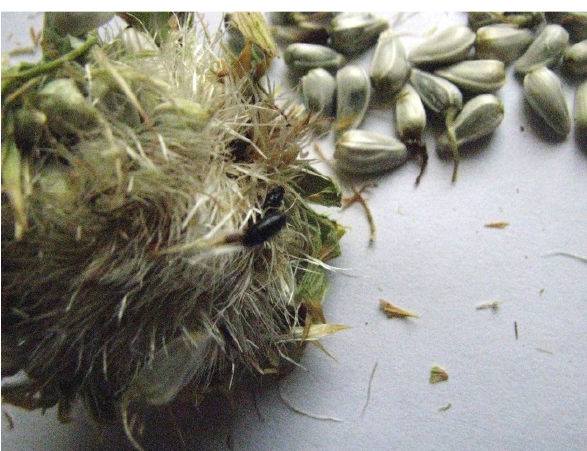
Fig. 6. Larva of Acanthiophilus helianthi Rossi inside flower head of safflower